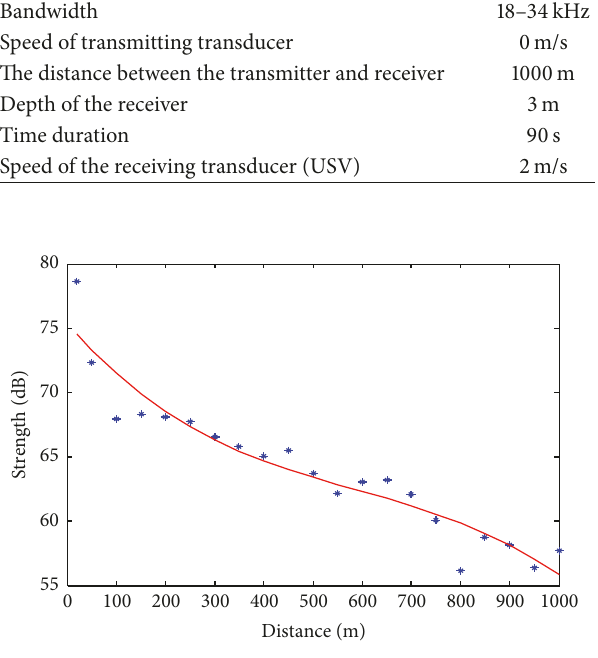
Figure 3: Fixed simulation results.